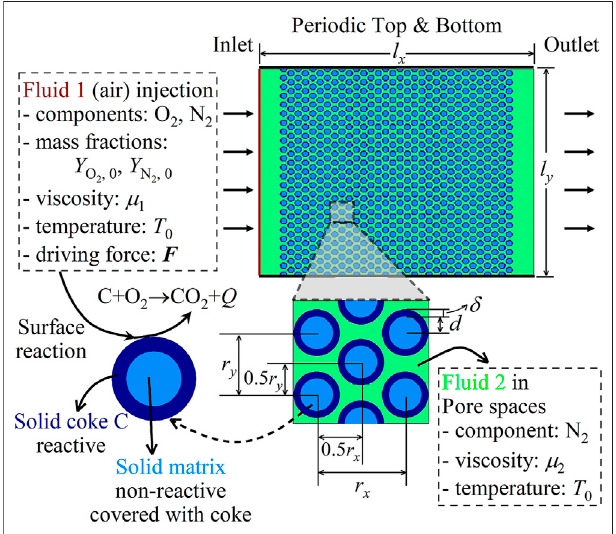
FIGURE 8 | Schematic of the problem: coke combustion in porous